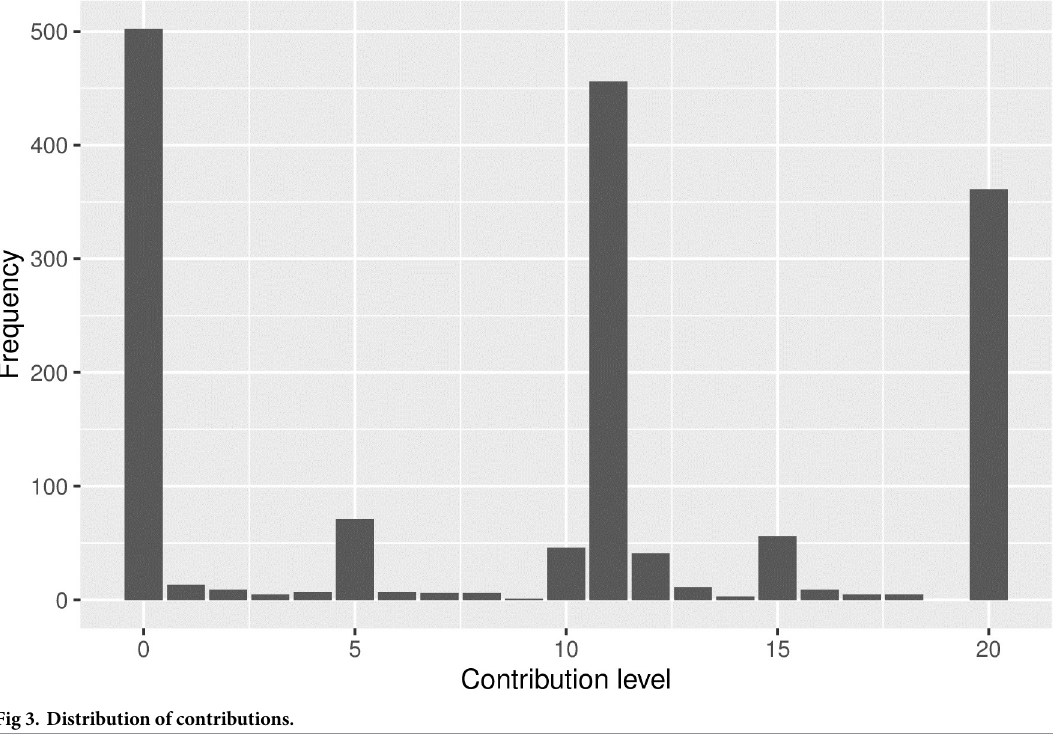
Fig 3. Distribution of contributions.